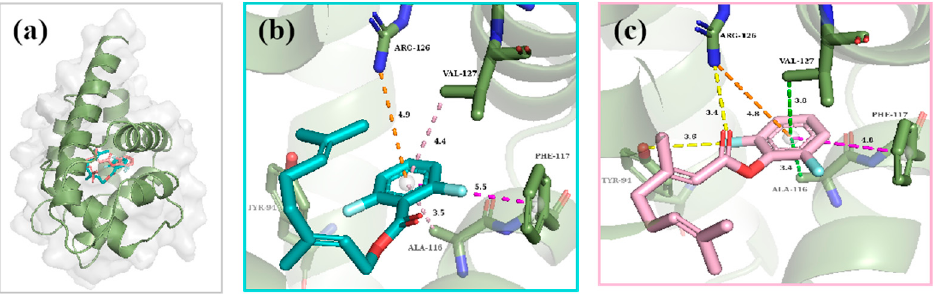
ab b Figure 4. ( a ) The order of the binding affinity of monosubstituents with ApisOBP9; ( b ) The positional effects of ortho -, meta- , and para- substituents on binding affinity. Data represent the mean ± standard deviation. A one-way analysis of variance (ANOVA) was performed followed by Duncan’s test (Different letters indicate values are significantly different ( p < 0.05)). 2.4. Molecular Docking of Ligands to ApisOBP9 To further study the molecular mechanisms of compounds binding with ApisOBP9, compounds CAU15 and 5w were selected as representative paired compounds to study the effect of ester group reversing, while 5e – 5g were selected as representative compounds to explore the position impact of substituents on benzene rings. The structure